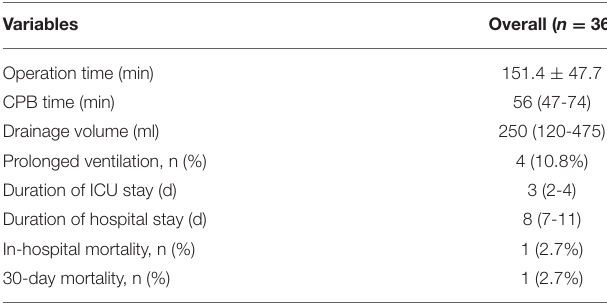
TABLE 2 | Baseline characteristics. TABLE 3 | Surgical details and postoperative